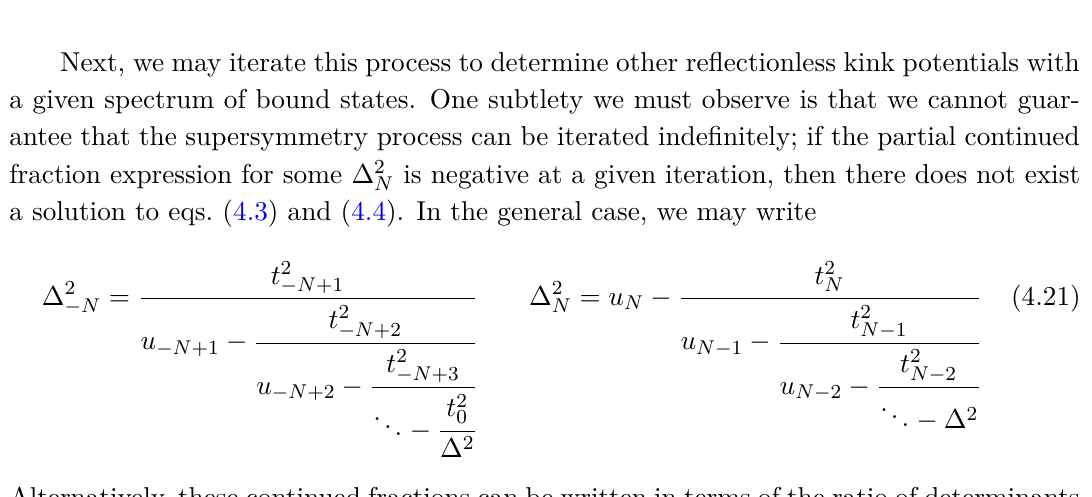
Figure 3 . A plot of the superpotential and the superhopping obtained from iterating discrete supersymmetry for four iterations starting with a constant potential. A constant shift is applied between iterations, and the corresponding solutions share the same spectrum apart from the con- stant shift and an additional bound state. These solutions correspond to one such hierarchy of kink